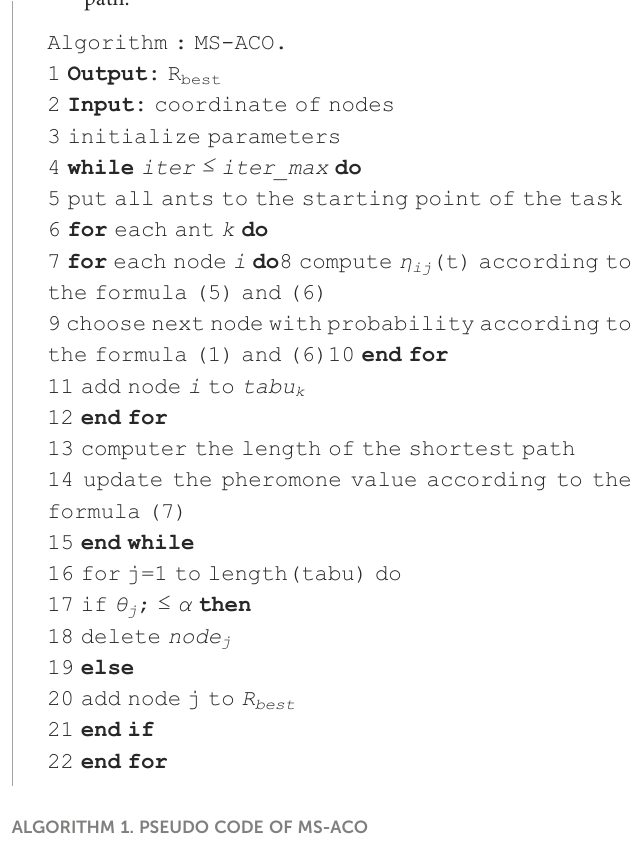
ALGORITHM 1. PSEUDO CODE OF MS-ACO